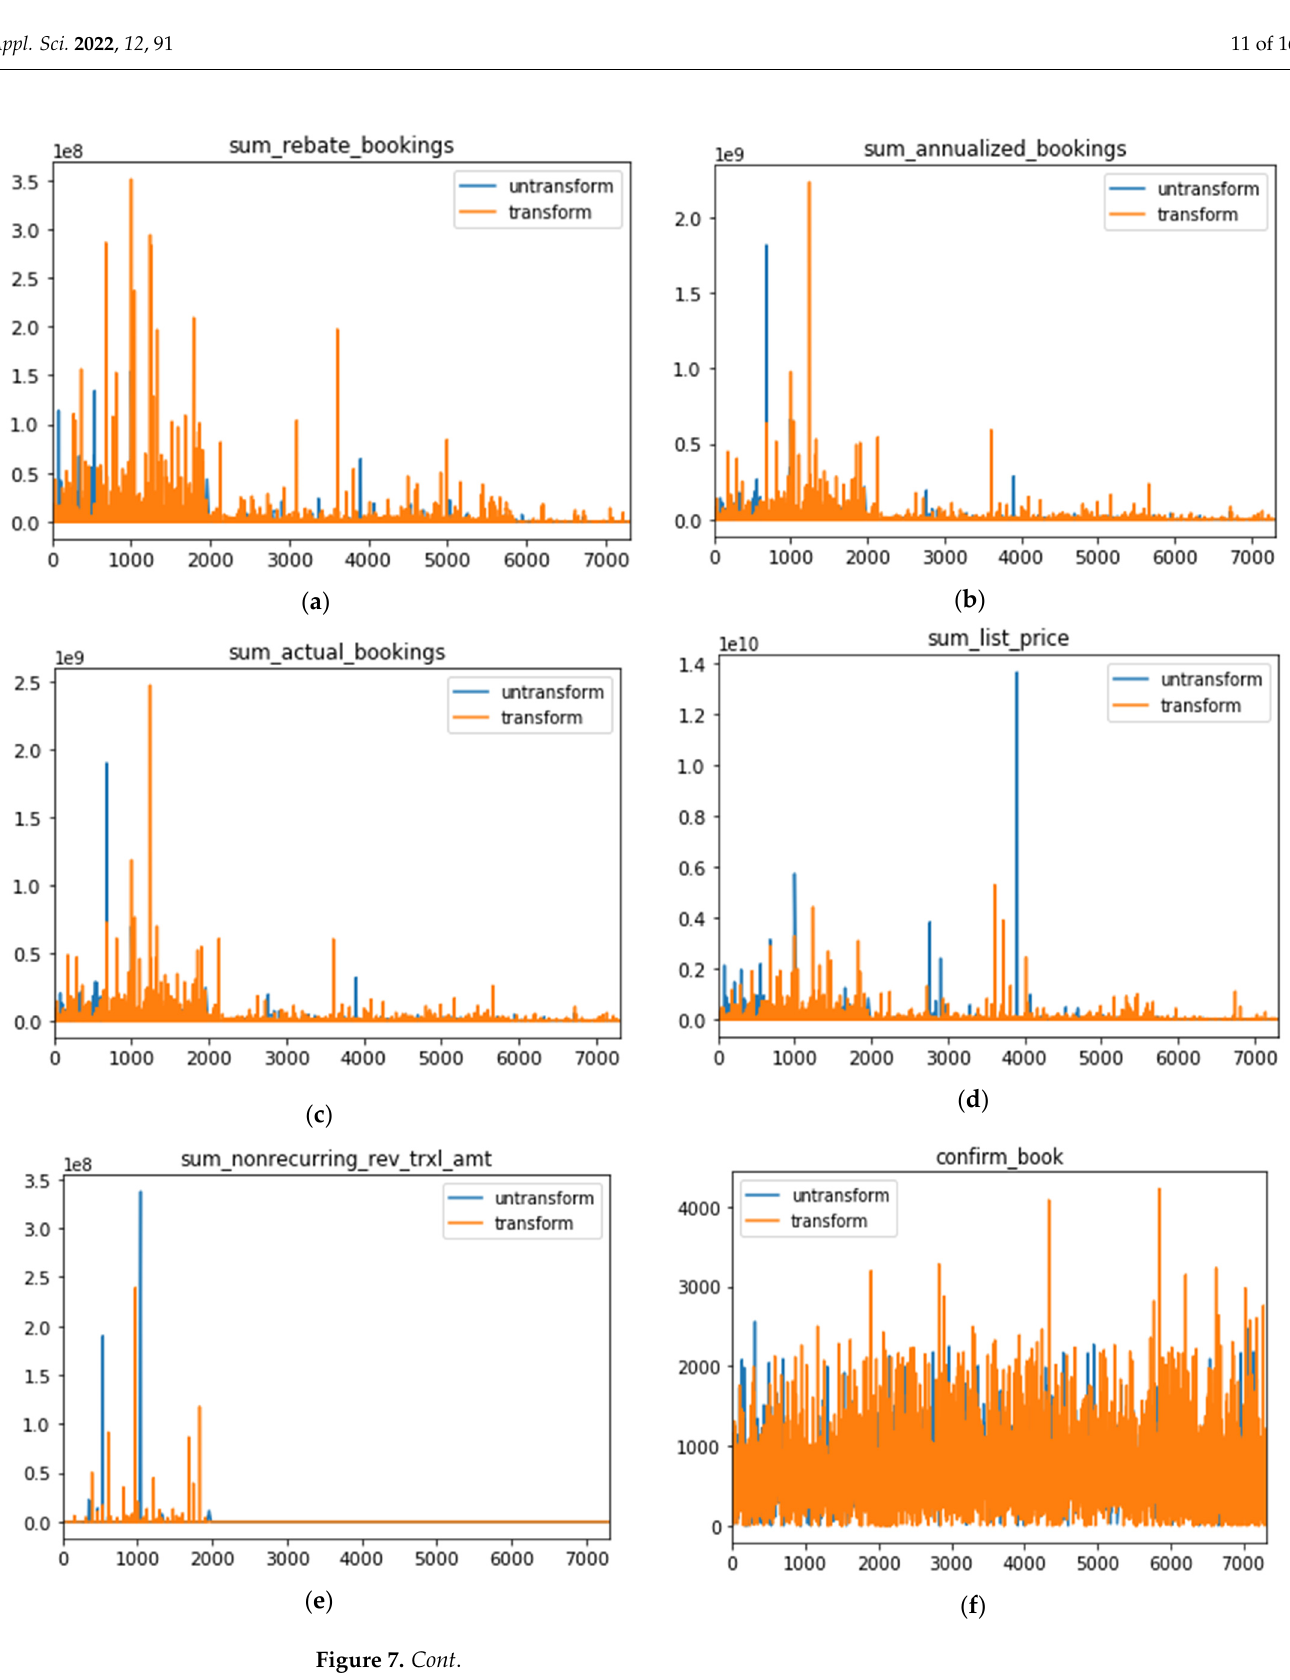
( h ) Figure 7. ( a)Comparing rebate booking attribute with two partner types; ( b ) Comparing annualized booking attribute with two partner types; ( c ) Comparing actual booking attribute with two partner types; ( d ) Comparing list price booking attribute with two partner types;( d ) Comparing list price booking attribute with two partner types;( e ) Comparing nonrecurring revenue attribute with two